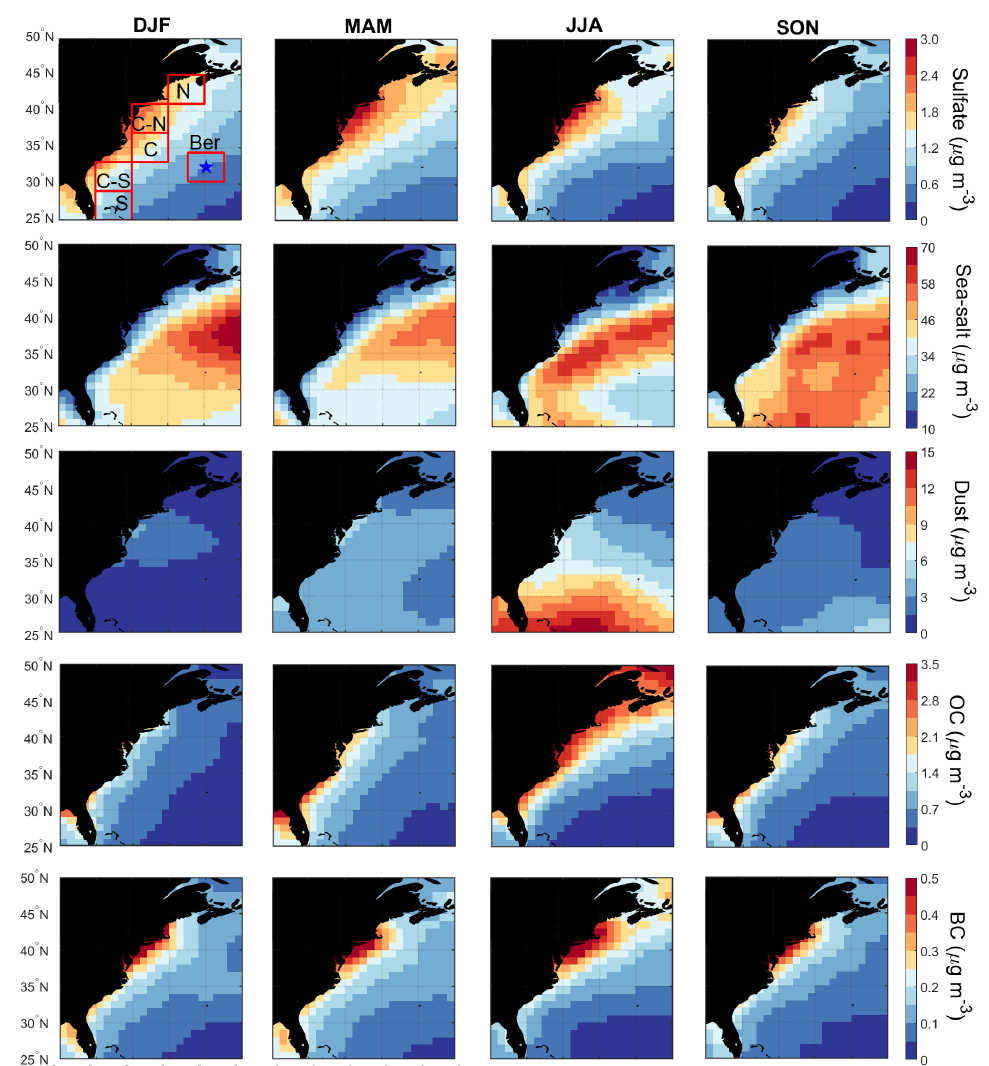
Figure 6. Seasonal maps of MERRA-2 speciated aerosol concentrations at the surface based on data between January 2013 and December 2017. The boxes in the top left panel represent sub-domains examined in more detail throughout the study, with the blue star denoting